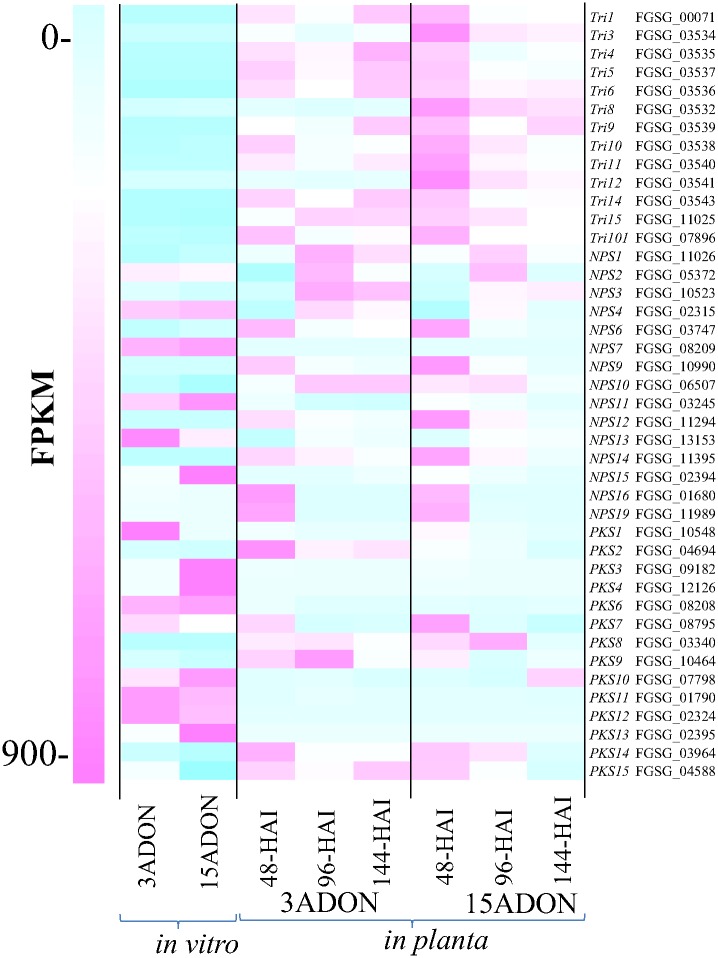
Expression of genes involved in biosynthesis of secondary metabolites.Expression level is the average of two replications.